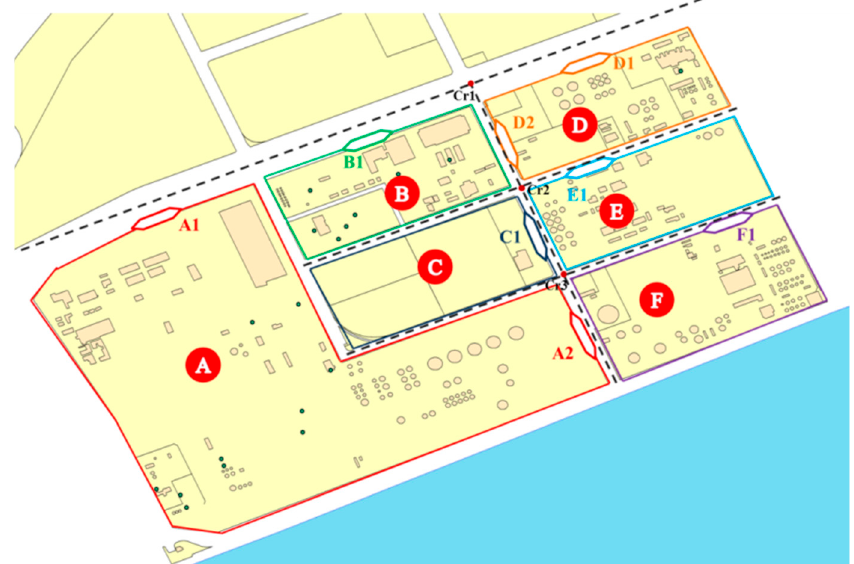
Figure 1. Layout of part of a chemical cluster in Shanghai.